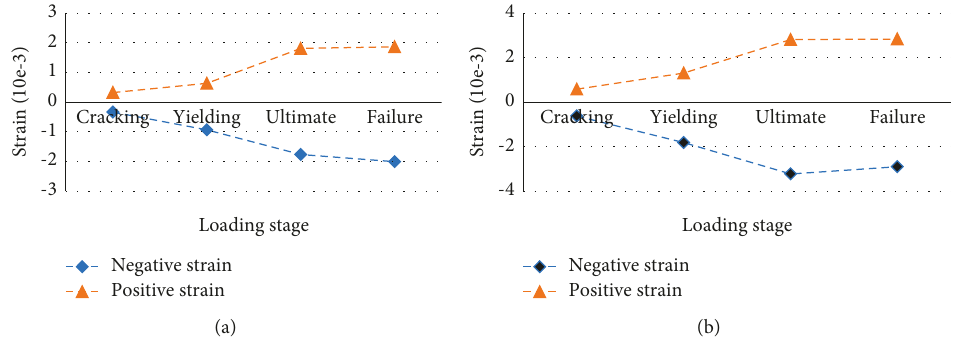
Figure 10: Strain distribution for SCCD11: (a) top steel reinforcement of the slab near the face of the column and (b) column longitudinal reinforcement near slab-column joint.